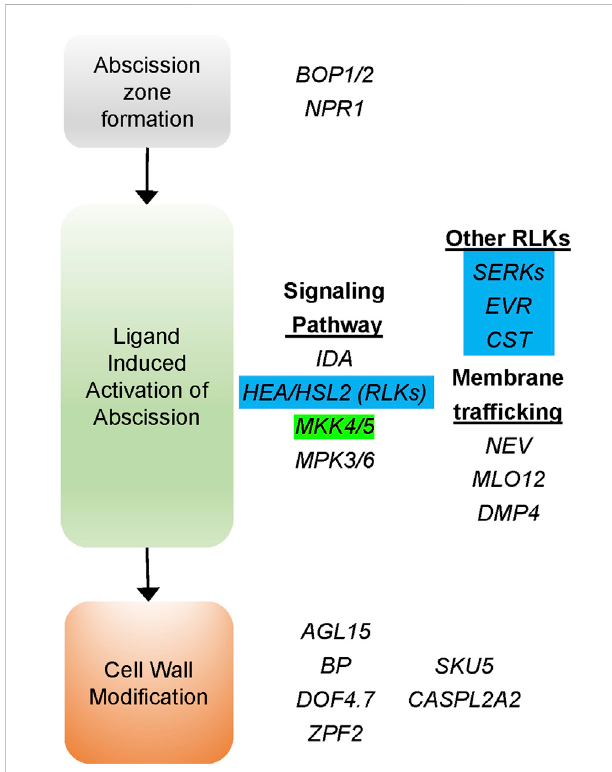
FIGURE 5 Genes affecting organ abscission based on Arabidopsis mutants that affect fl oral organ abscission. Several likekinases (RLKs) are involved in the signaling pathway promoting the activation of abscission induced by interaction with the IDA ligand. Pepper homologs encoding four of these proteins were identi fi ed within destemming QTL intervals (highlighted in blue). In addition, a gene encoding the pepper homolog of the signal transduction kinase MITOGEN-ACTIVATED PROTEIN KINASE KINASE5 (MKK5) (highlighted in green) was also found under the dstem3.2